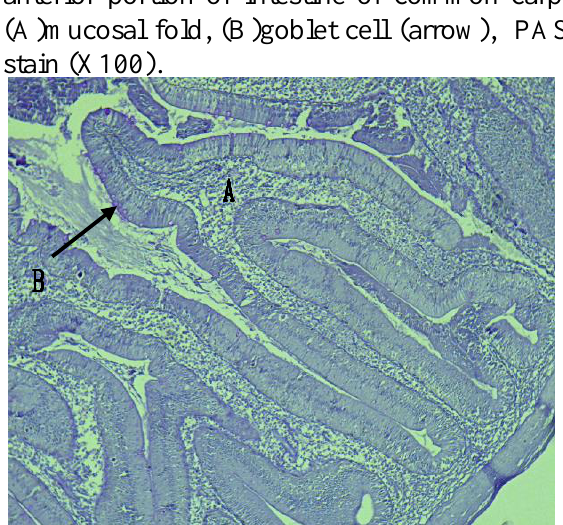
Figure, 6: Cross microscopic section of middle portion of intestine of common carp, (A)mucosal fold, (B)goblet cell (arrow),PAS stain (X100).